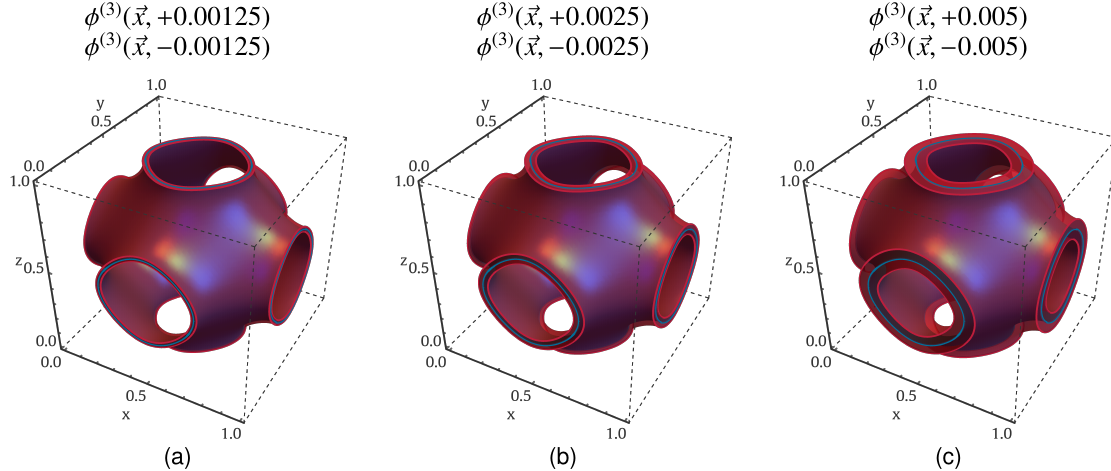
Figure 4. Infill volume enclosed between two offset contours from the original Schwarz P interface F Sch ( (cid:126) x ) = 0. For a unit cell, the offset distance is 0.00125 in ( a ), 0.0025 in ( b ), and 0.005 in ( c ). The third-order offset function was